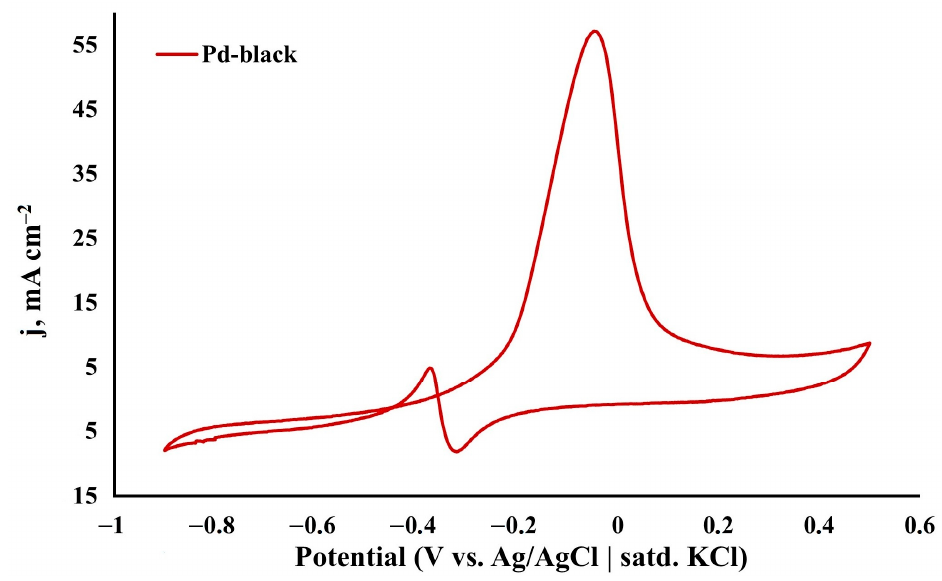
Figure 11. Cyclic voltammogram of a palladium catalyst.